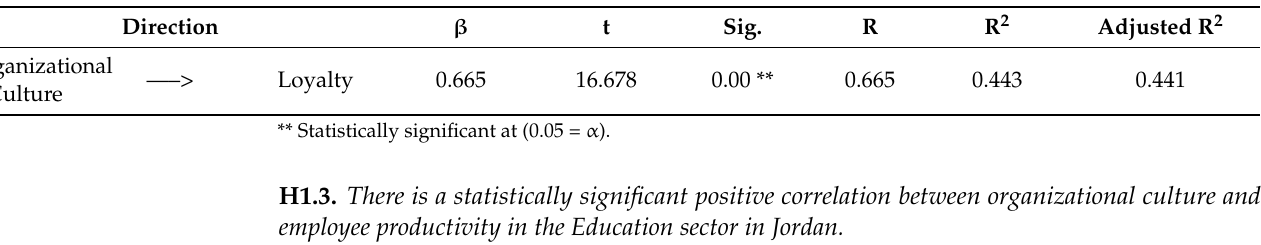
Table 7. Results of the analysis.